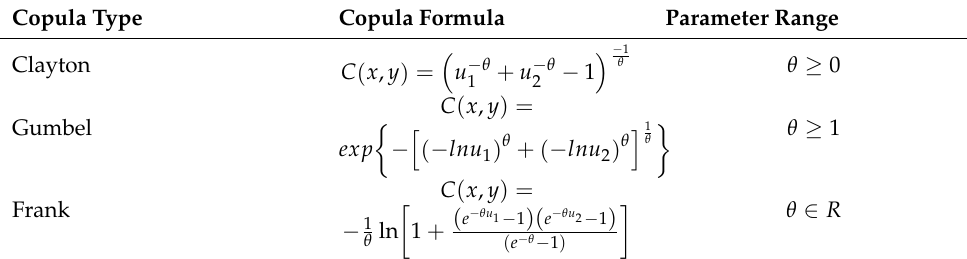
Table 2. Archimedean copula function